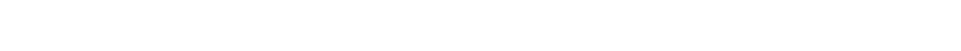
FIGURE 1 | Site map showing Lake BrayaSø in the Kangerlussuaq region, Greenland. Modified from D’Andrea et al.